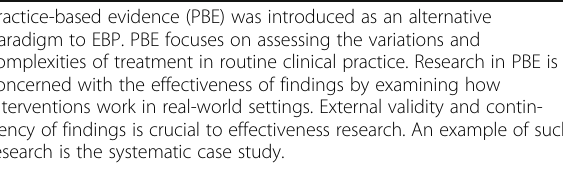
Table 4 Key concept: practice-based evidence (PBE)